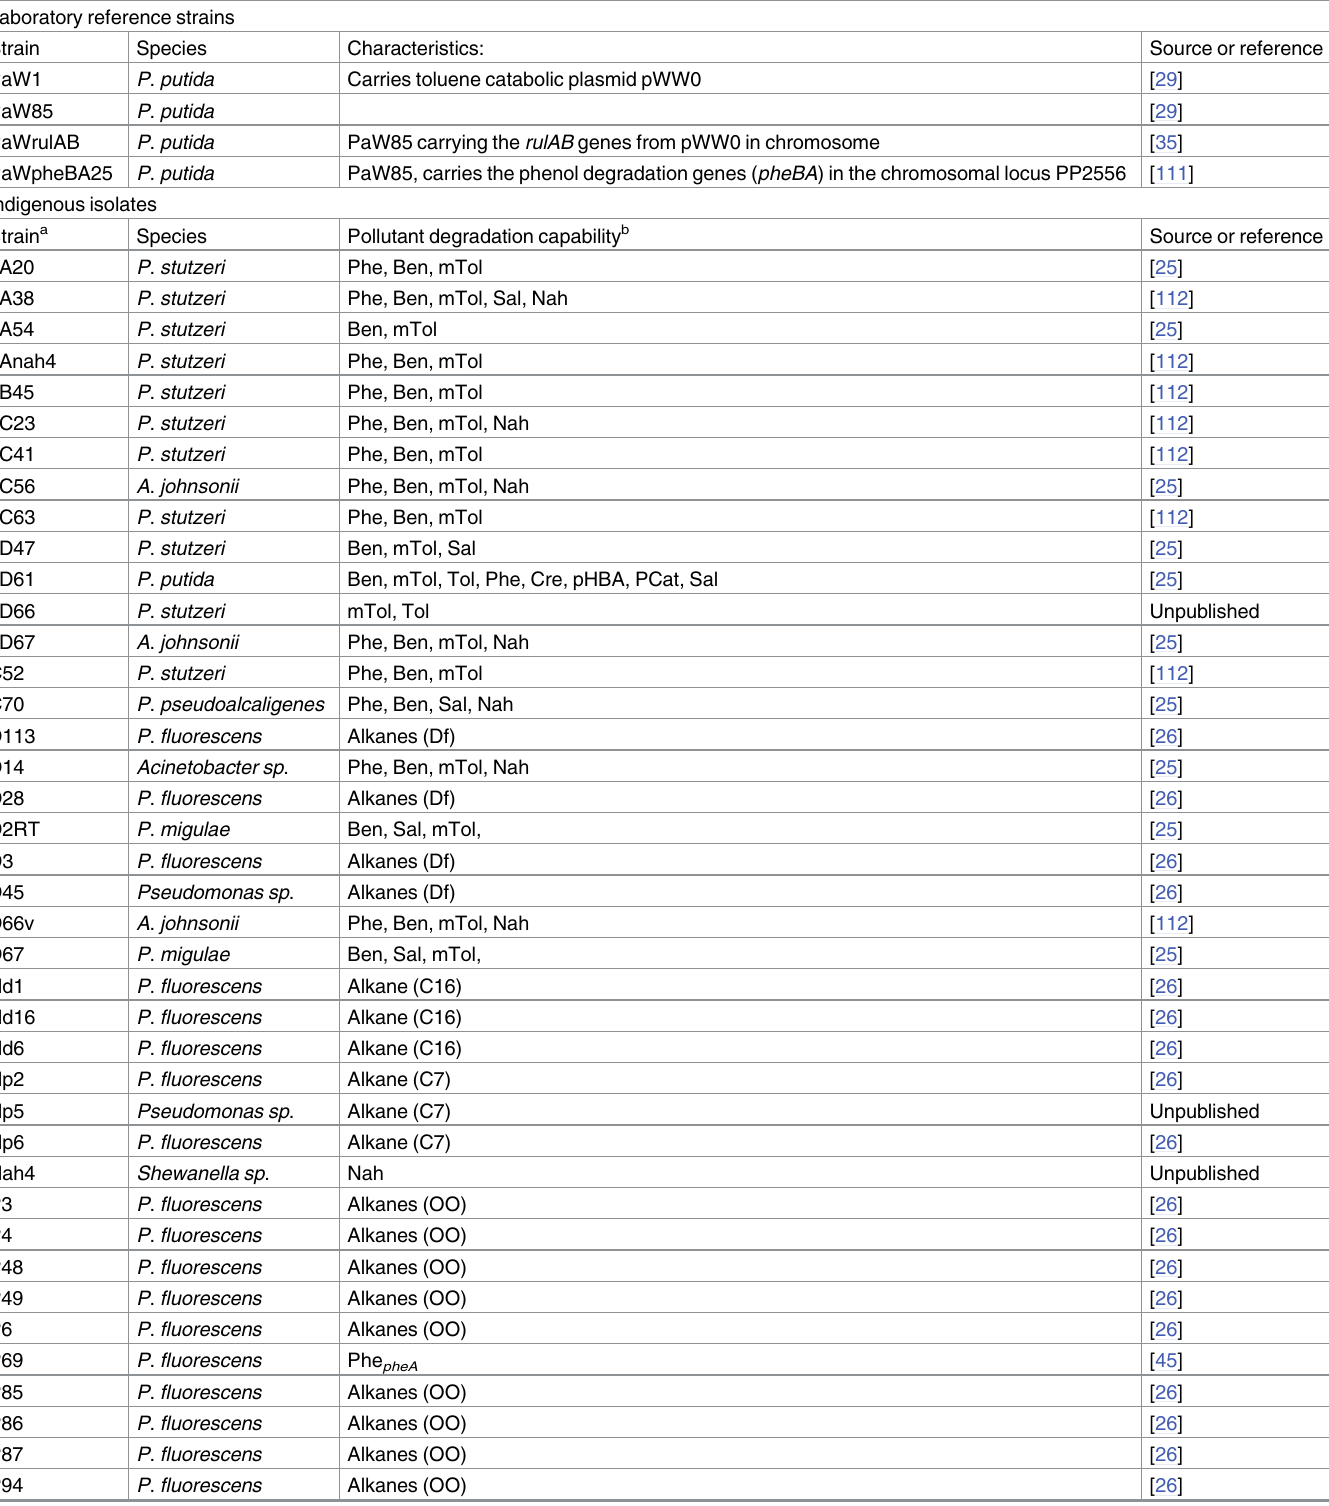
Table 1. The bacterial strains used in this study. Laboratory reference strains Strain